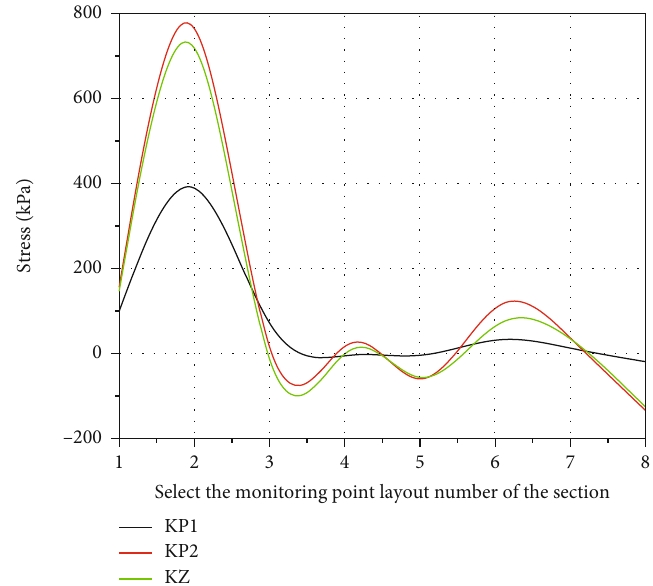
Figure 7: Stress distribution curve of each measuring point of the section.